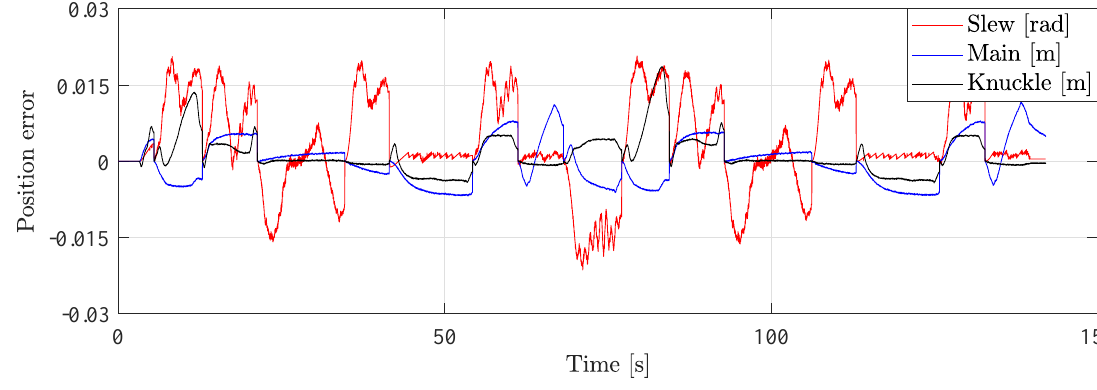
Figure 18. Position error from laboratory